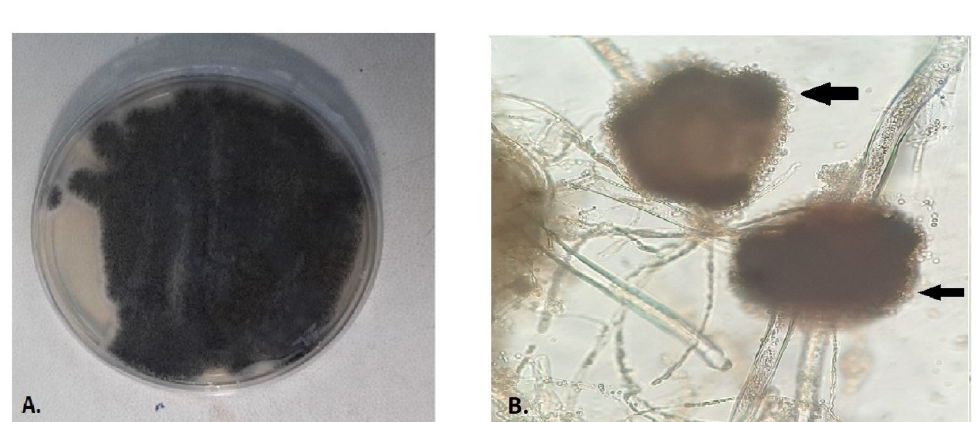
Figure 1. Growth of Aspergillus spp. on Sabouraud Dextrose agar at 37 ◦ C after 48 h ( A ) and microscopic examination of the cultured fungus at 40 × magnification (some fungal colonies were picked up with adhesive tape, placed on clean glass slide, and covered with a slip). The arrows indicate the conidiophore with phialides covering its entire surface ( B ).